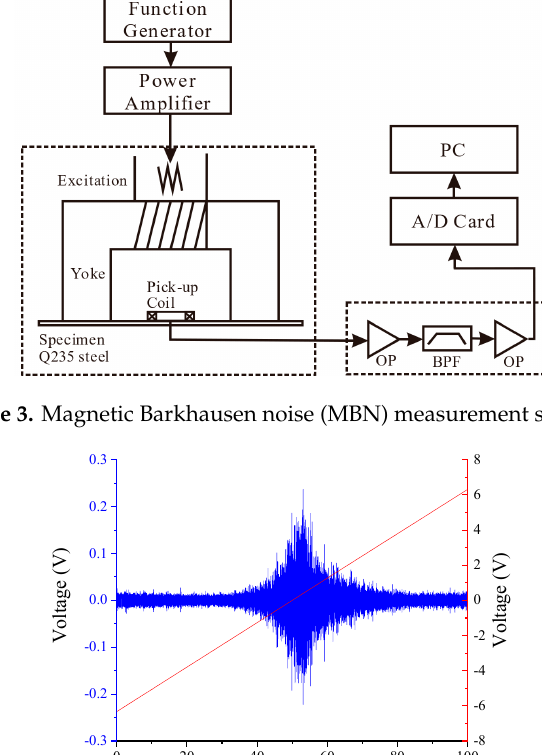
Figure 4. Example of an MBN signal and excitation signal. The red curve is the excitation signal and the blue one is the MBN signal.